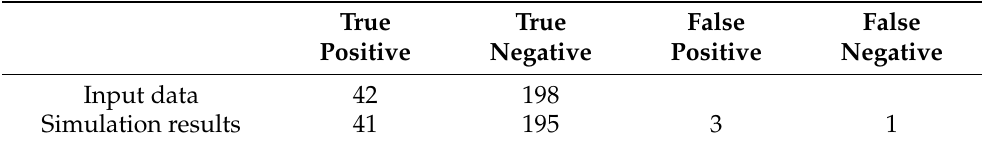
Table 1. Results of test data analysis using NET1_HF neural network.